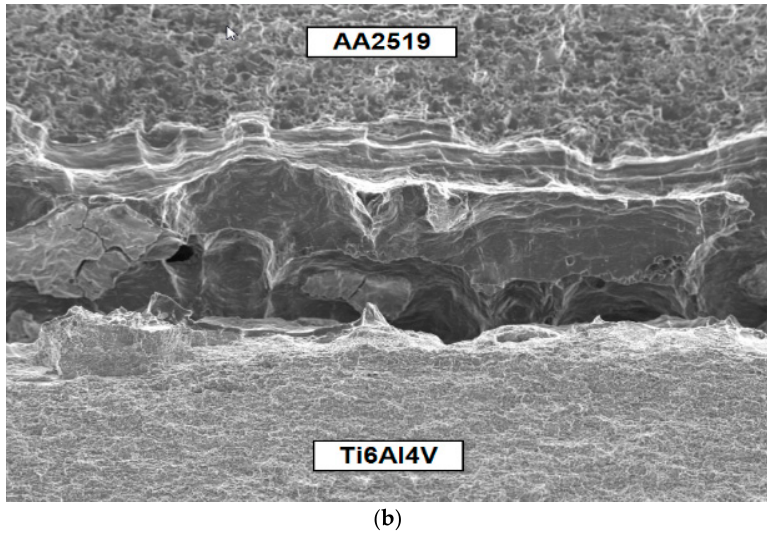
Figure 4. Nature of the delamination crack. ( a ) tests at T 1 = 20 °C; ( b ) tests at T 2 = − 50 °C.